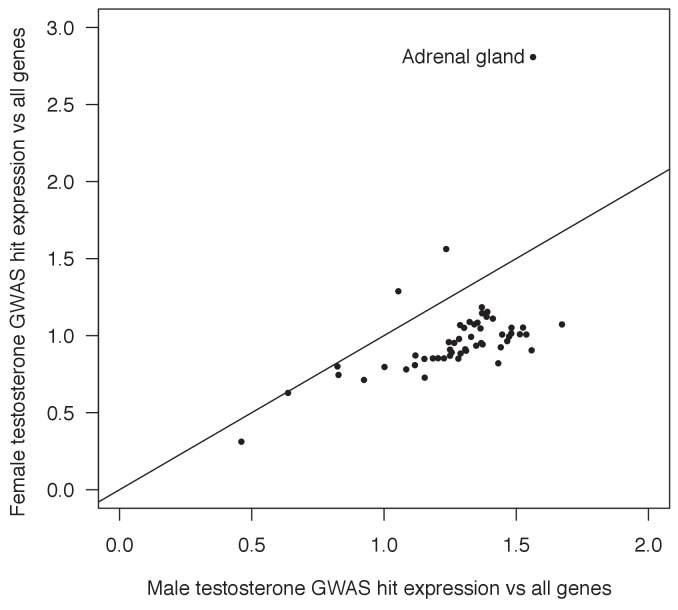
Mean expression of testosterone GWAS hits in females or males (defined as mean log-transformed counts of hits divided by mean log-transformed counts of all genes) in each of 48 GTEx tissues.